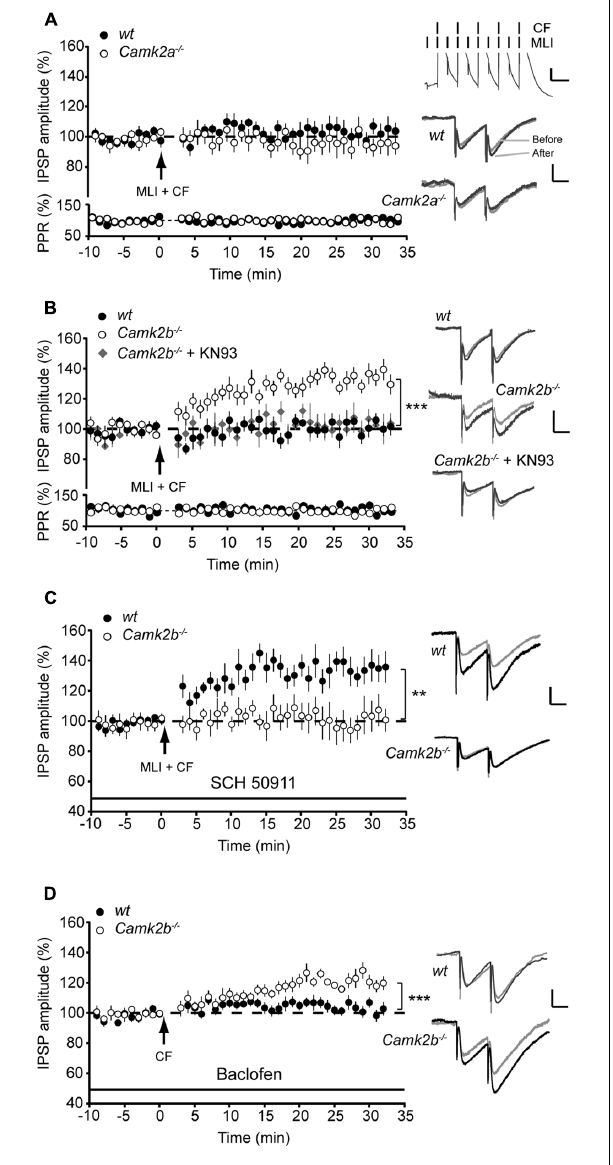
FIGURE 3 | GABA B -receptor activation facilitates iLTP in Camk2b − / − but not in Camk2a − / − mice. ( A ;Top) Paired molecular layer interneuron (MLI; 20 Hz) and climbing fiber (CF; 5 pulses, 10 Hz) stimulation every 2 s for 3 min yields no change in IPSP amplitude in both wt ( n = 10) and Camk2a − / − ( n = 8) Purkinje cells. (Bottom) Accompanying paired pulse ratio of IPSPs. Inset: representative traces of MLI-CF stimulation, scale bars 3 mV/100 ms and representative traces of IPSP before and after the CF stimulation, scale bars 1 mV/25 ms. (B) Paired MLI-CF stimulation yields no change in IPSP amplitude in wt Purkinje cells ( n = 10) and in Camk2b − / − Purkinje cells when KN93 is present ( Camk2b − / − + KN93, n = 5). MLI-CF stimulation significantly facilitates iLTP in Camk2b − / − Purkinje cells ( n = 13). (C) Inhibition of GABA B -receptor activation with SCH 50911 rescues iLTP in wt Purkinje cells ( n = 9), but inhibits iLTP in Camk2b − / − Purkinje cells ( n = 7) following paired SC–CF stimulation. (D) Activation of GABA B -receptors with baclofen inhibits iLTP in wt Purkinje cells ( n = 10), but facilitates iLTP in Camk2b − / − cells ( n = 8) following CF stimulation. Error bars represent SEM. Asterisks with brackets indicate statistical significance between wt and knockout mice (Student’s t -test of averages over last 5 min). ** p < 0.01; *** p <